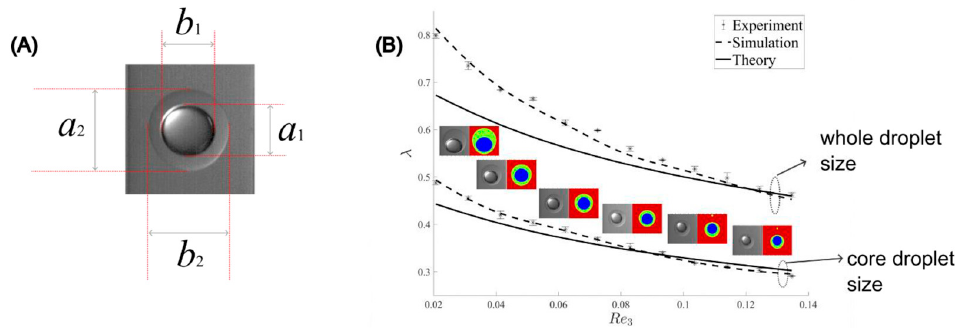
Figure 8 Figure 8. Matched droplets: ( A ) core and shell droplet diameter measurement; ( B ) size distribution comparisons among experiments, simulations, and